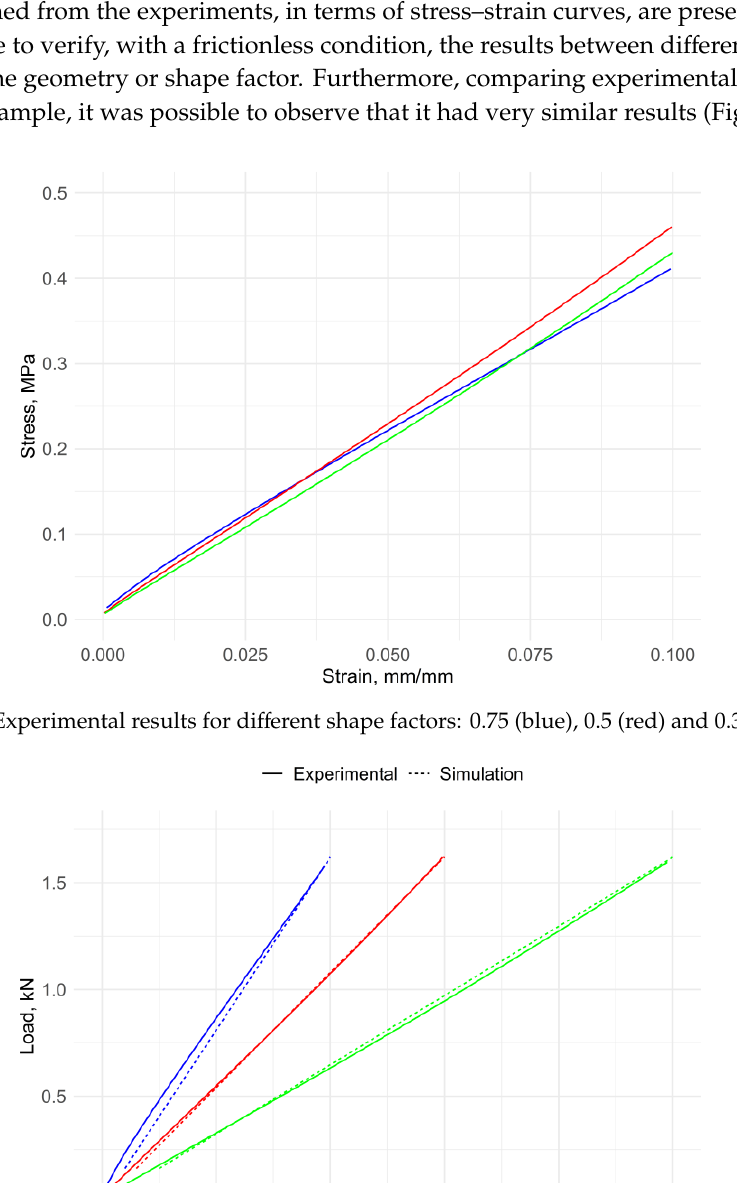
Figure 4. Stress–strain plot of a cork–rubber composite with frictional contact between loading surfaces (solid line).